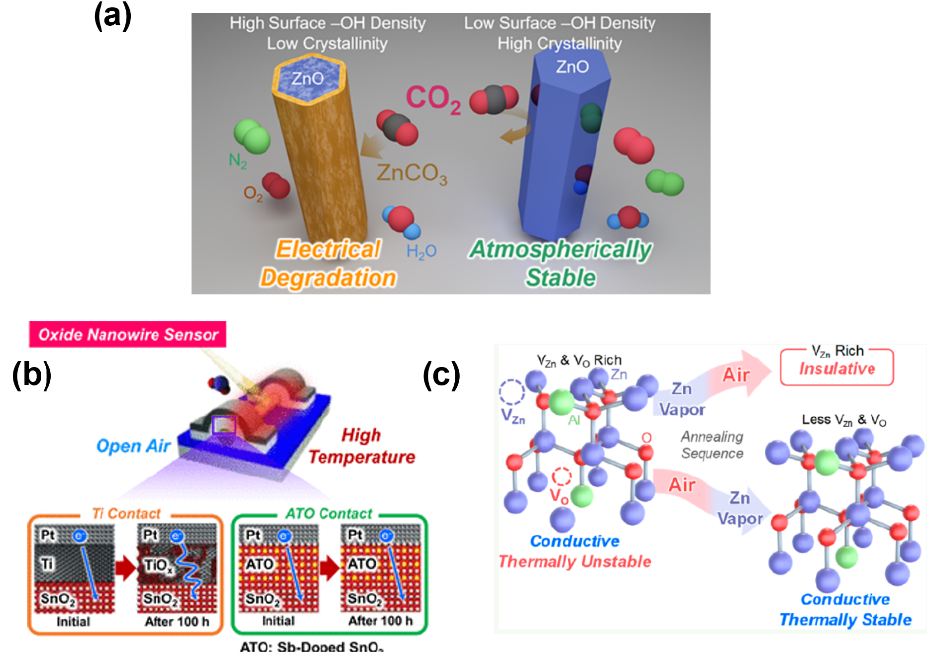
Figure 27. ( a ) Atmospherically stable ZnO nanowires via using the annealing process. Reprinted from reference [74] with permission from the American Chemical Society; ( b ) gas sensor with long- term stability via using heavily doped oxide as the contact. ATO, Sb-doped SnO 2 . Reprinted from reference [73] with permission from the American Chemical Society; ( c ) Al-doped ZnO thin film with thermal stability via using sequential annealing. Reprinted from reference [360] with permission from the American Chemical Society.